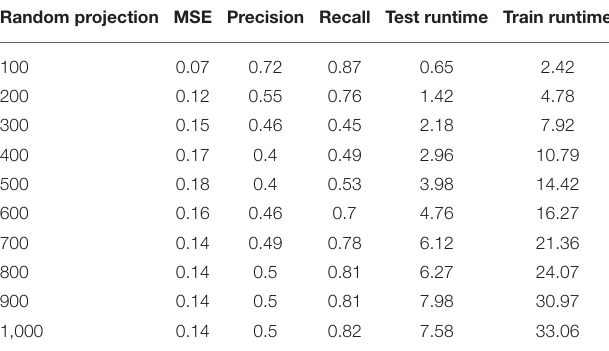
TABLE 5 | Errors of classifying ads dataset using QDA attribute selection method.